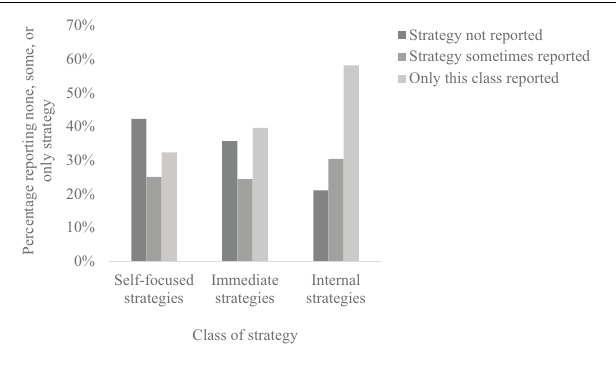
FIGURE 1 | Bar graph demonstrating proportions of the sample reporting none, some, or only self-focused, immediate, and internal compassion maintaining